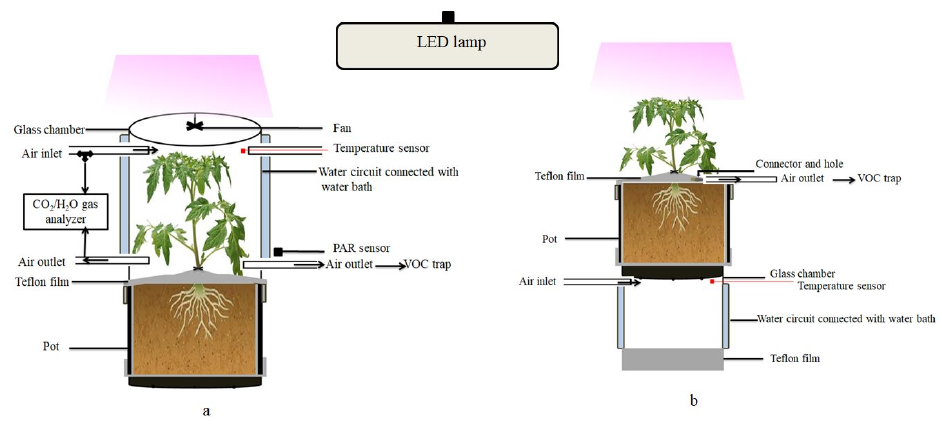
Figure 4. Schematic of the dynamic enclosure system used for the measurement of VOC emissions from the entire foliage ( a ) or from the soil surface ( b ) of tomato plants. The arrows indicate the direction of the airflow. The double walled middle section of the chamber with the temperature- regulated water circuit is shown in blue.